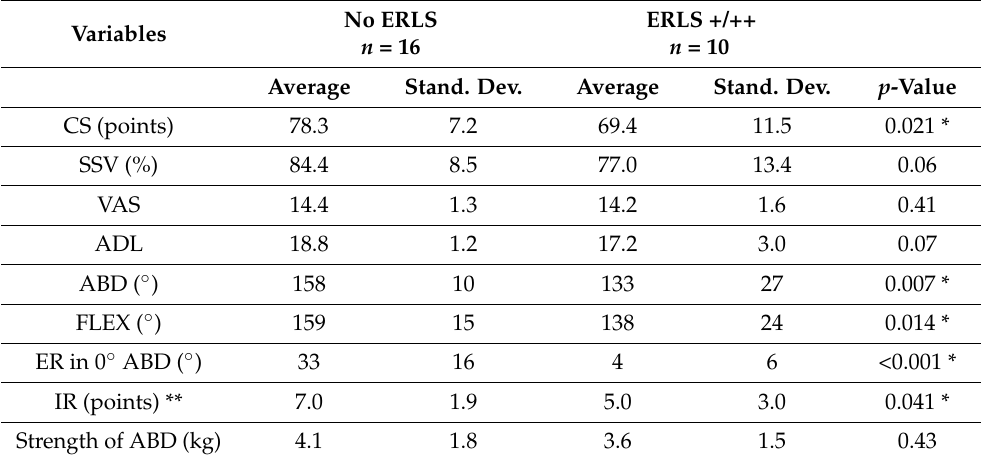
Table 4. Comparison of subjective satisfaction and function with regards to patients that show a positive external rotation lag signs